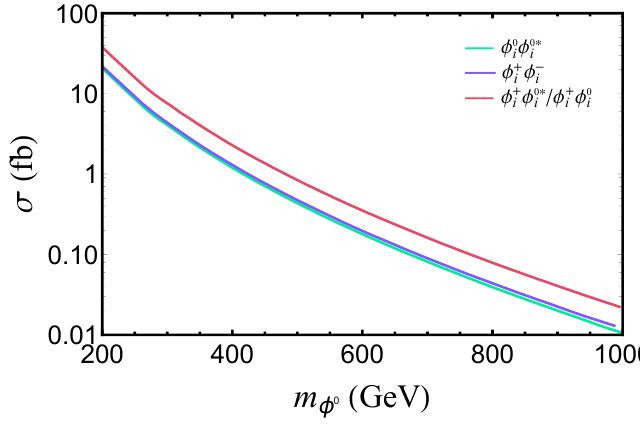
Figure 10 . Di-Higgs production cross-section at the LHC in the SU(2) H